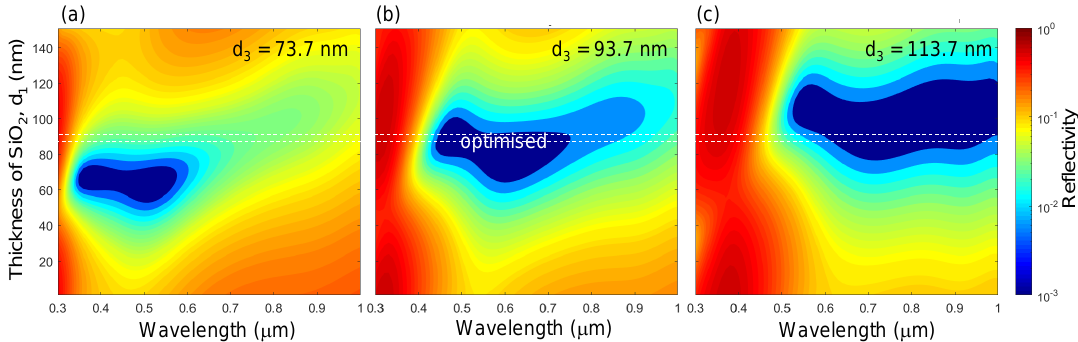
thickness effect on the performance of SiO 2